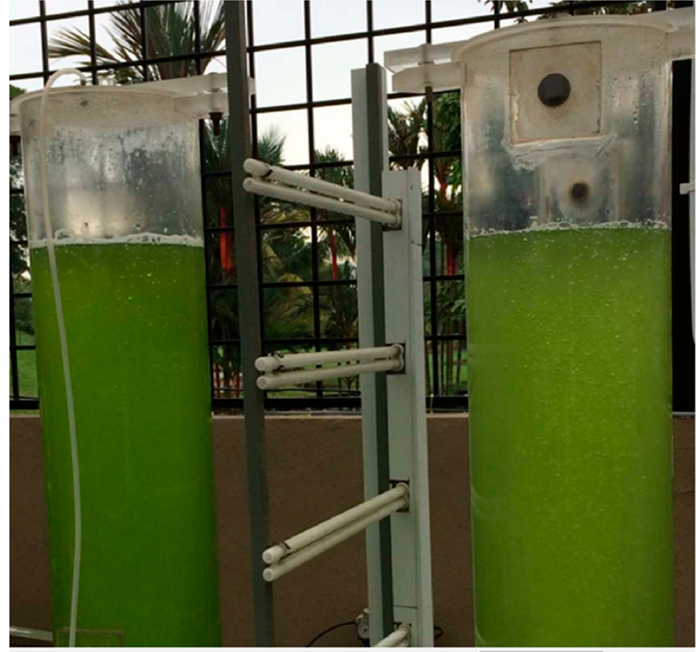
Figure 3. Model of tubular photobioreactors [59].